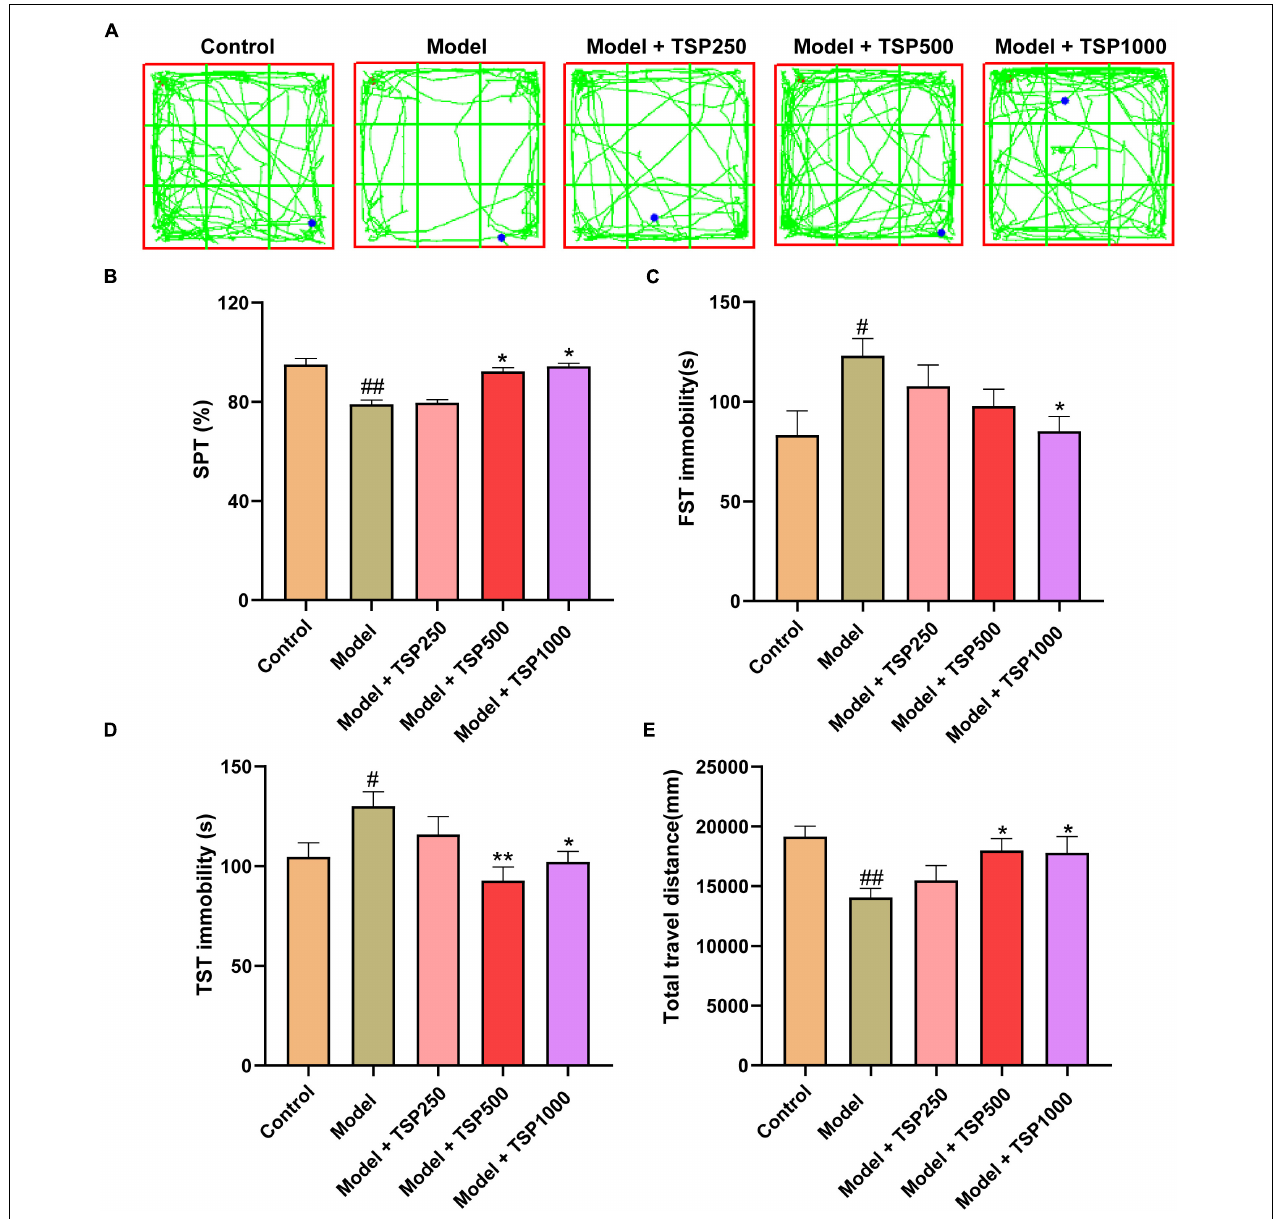
FIGURE 2 | The effects of TSP on anxiety- and depression-like behavior. (A) The representative tracks of the OFT experiment. The anxiety- and depression-like behavior was observed via SPT (B) , FST (C) , TST (D) , and OFT (E) experiments. All data were expressed as mean ± SEM ( n = 15). # P < 0.05, ## P < 0.01 vs. Control group; * P < 0.05, ** P < 0.01 vs. Model